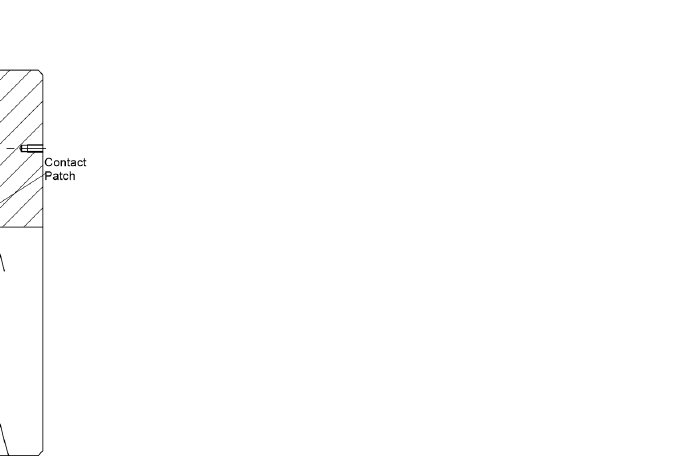
Figure 7. Cross-section of clamp showing the angled contact section between flange and clamp.